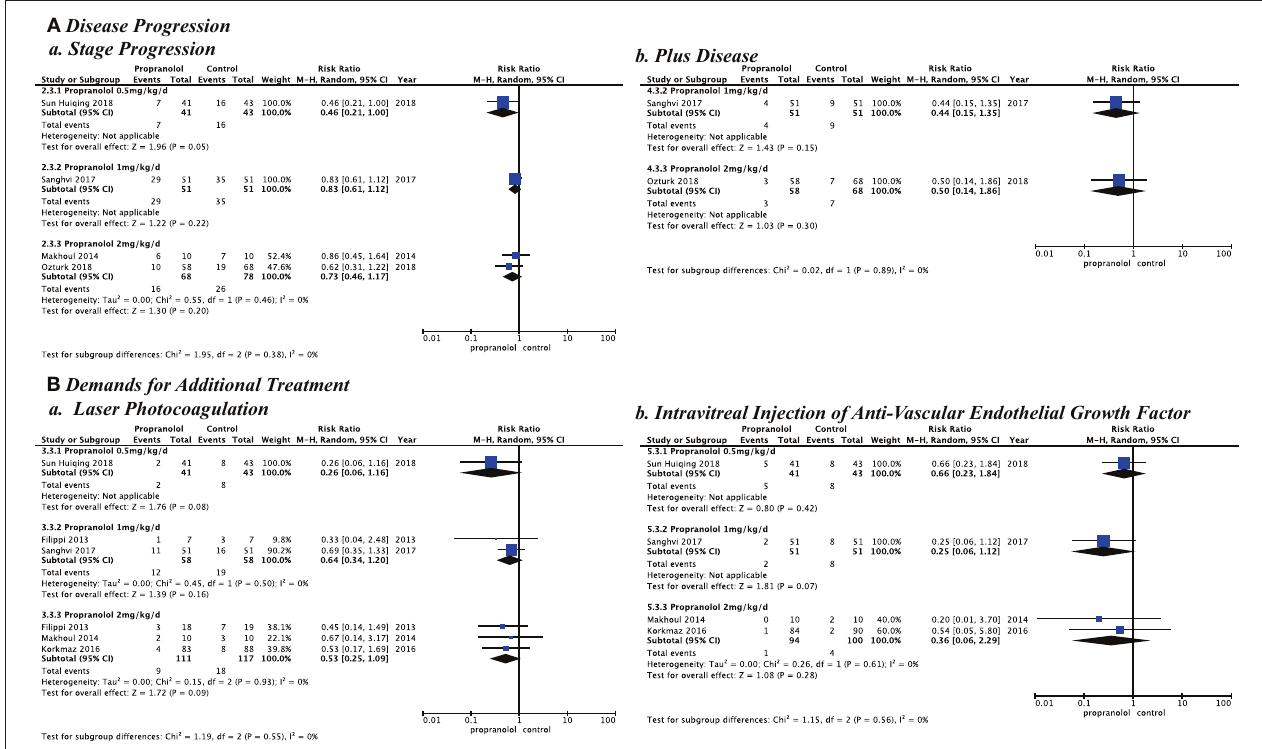
FIGURE 6 | Subgroup analysis with different doses of propranolol oral administration when starting to prevent or treat. (A) Disease progression and (B) Demands for additional